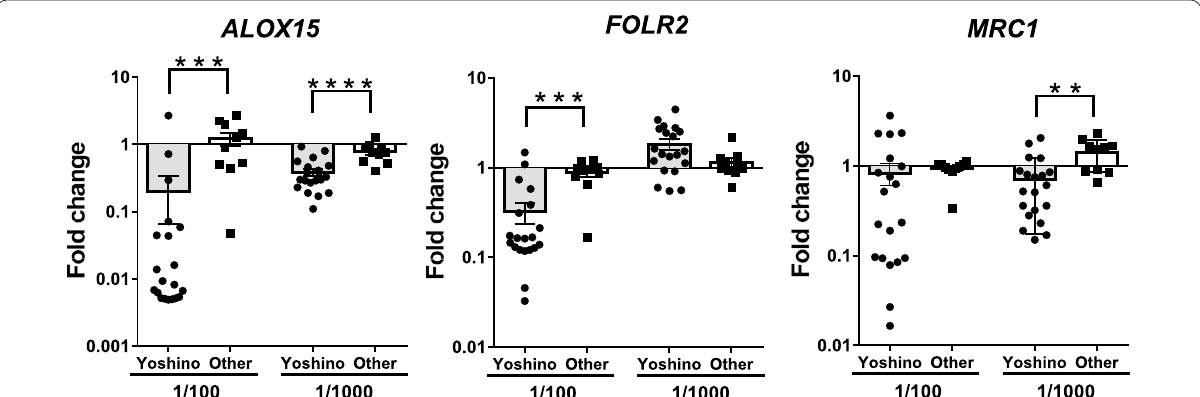
Fig. 2 Effect of Cryptomeria japonica on M2 macrophage polarization. Gene expressions of the M2 macrophage markers ALOX15 , FOLR2 and MRC1 in human‑derived macrophages stimulated by Cryptomeria japonica from Yoshino ( n error of the mean. *** P < 0.001, **** P < 0.0001 (Mann–Whitney U test)